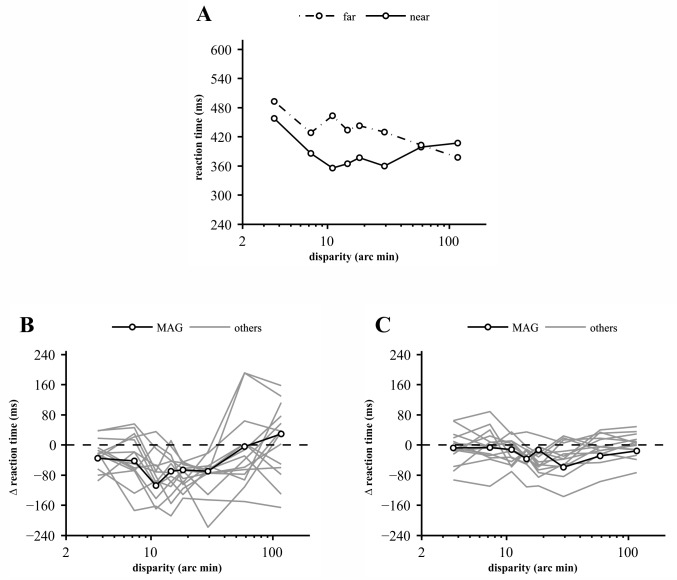
The difference between reaction times to near and far disparity DRDS checkerboards at 10% and at 90% contrast.(A) Median reaction times of participant MAG for near (solid lines) and far (broken lines) disparity DRDS checkerboards at 10% contrast. Each data point represents the median of up to 10 valid responses. This participant responded slower to far targets of all disparity magnitudes except for the largest one. (B) The difference between reaction times to near and far disparity DRDS checkerboards at 10% contrast for all participants. Data of participant MAG (shown in A) are plotted by solid black line and open circles; the remaining participants are plotted by gray lines. Note that reaction times to near disparities were always shorter in the middle of the tested disparity range. (C) The same as B for 90% contrast.